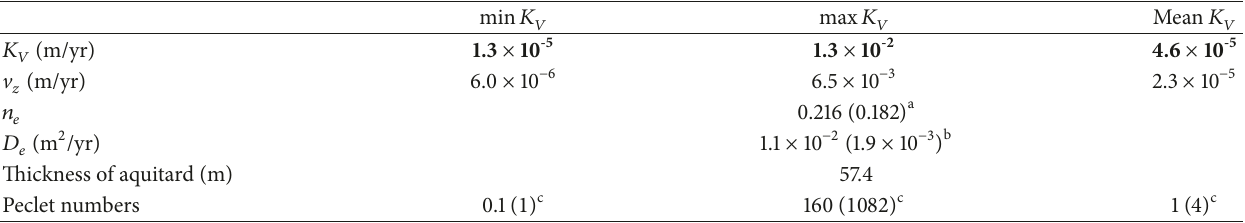
Table 3: Measured aquitard core properties bolded [53] and calculated vertical flow velocities, diffusion coefficients, geochemical porosity, and Peclet numbers for 4 He and in brackets for chloride.